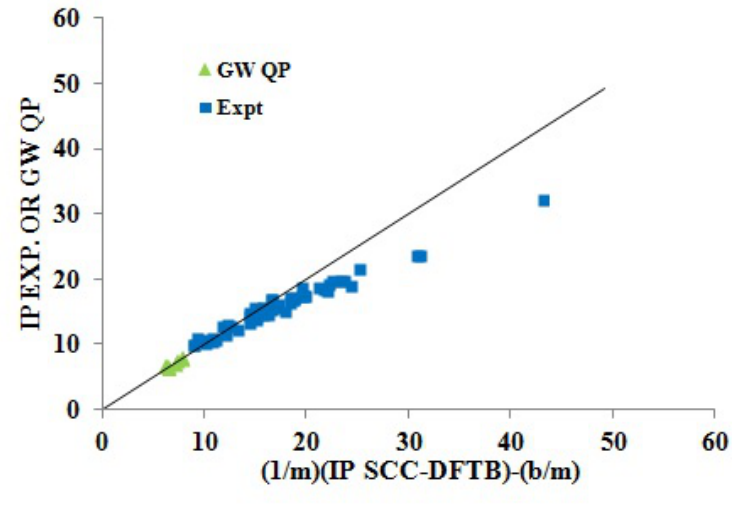
Figure 10. Inversion plot showing how fitting parameters obtained for the SCC-DFTB KT IPs and medium-sized molecules predict the GW QP IPs of medium-sized molecules and the experimental IPs of small molecules.